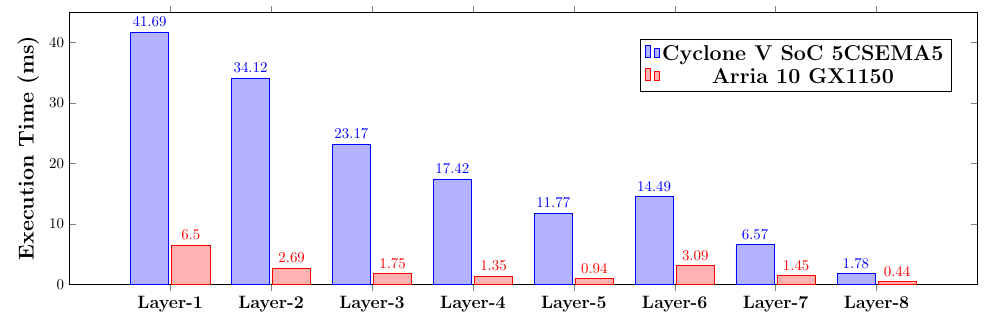
Figure 8. Detailed breakdown of execution time for each layer of AlexNet. A Layer here means execution of one round of pipelined kernels as shown in Figure 6. In case of AlexNet Layer-1 to Layer-5 are combination of memory read/write, convolution and pooling kernels, while Layer-5 to Layer-7 are combination of memory read/write and fully connected kernels.